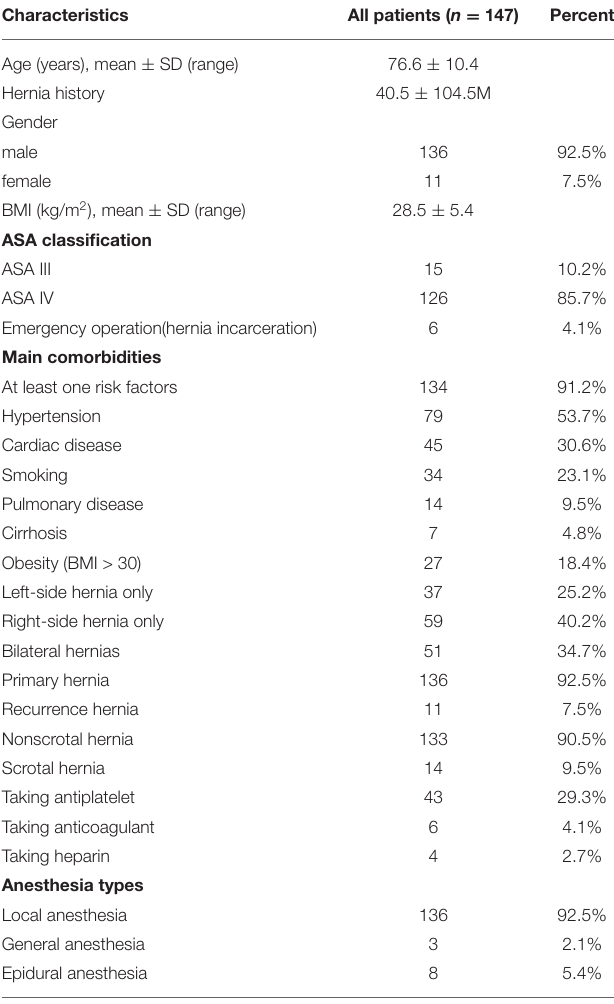
TABLE 1 | Patient demography and preoperative